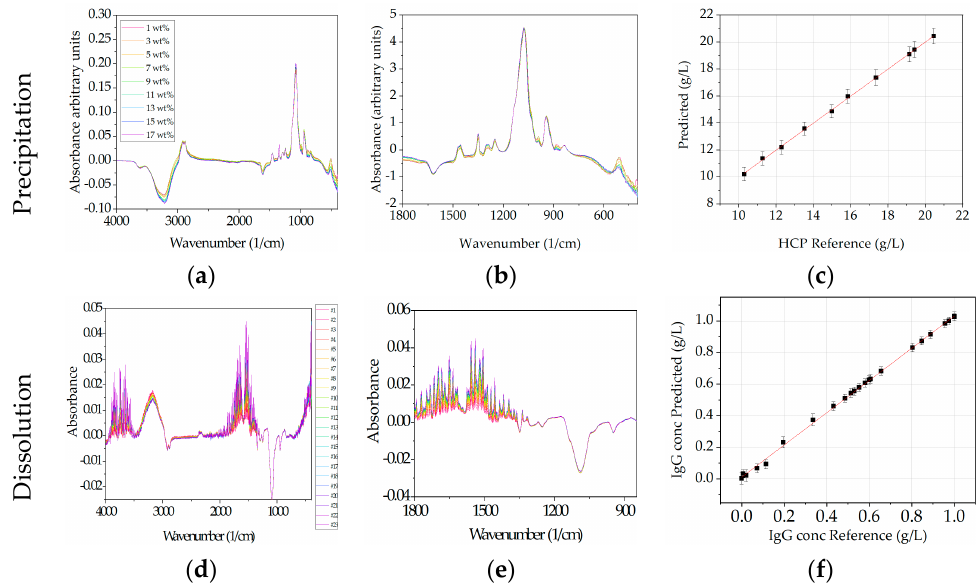
Figure 11. FTIR spectral data for precipitation ( a – c ) and dissolution ( d – f ). ( a , c ) raw data, ( b , e ) preprocessed data and ( c , f ) show the PLS regression results. The sample order is sorted from red to blue. Sample names are equal in each row and are always shown in ( a , d ). Spectral data ( d – f ) have been previously published [6].